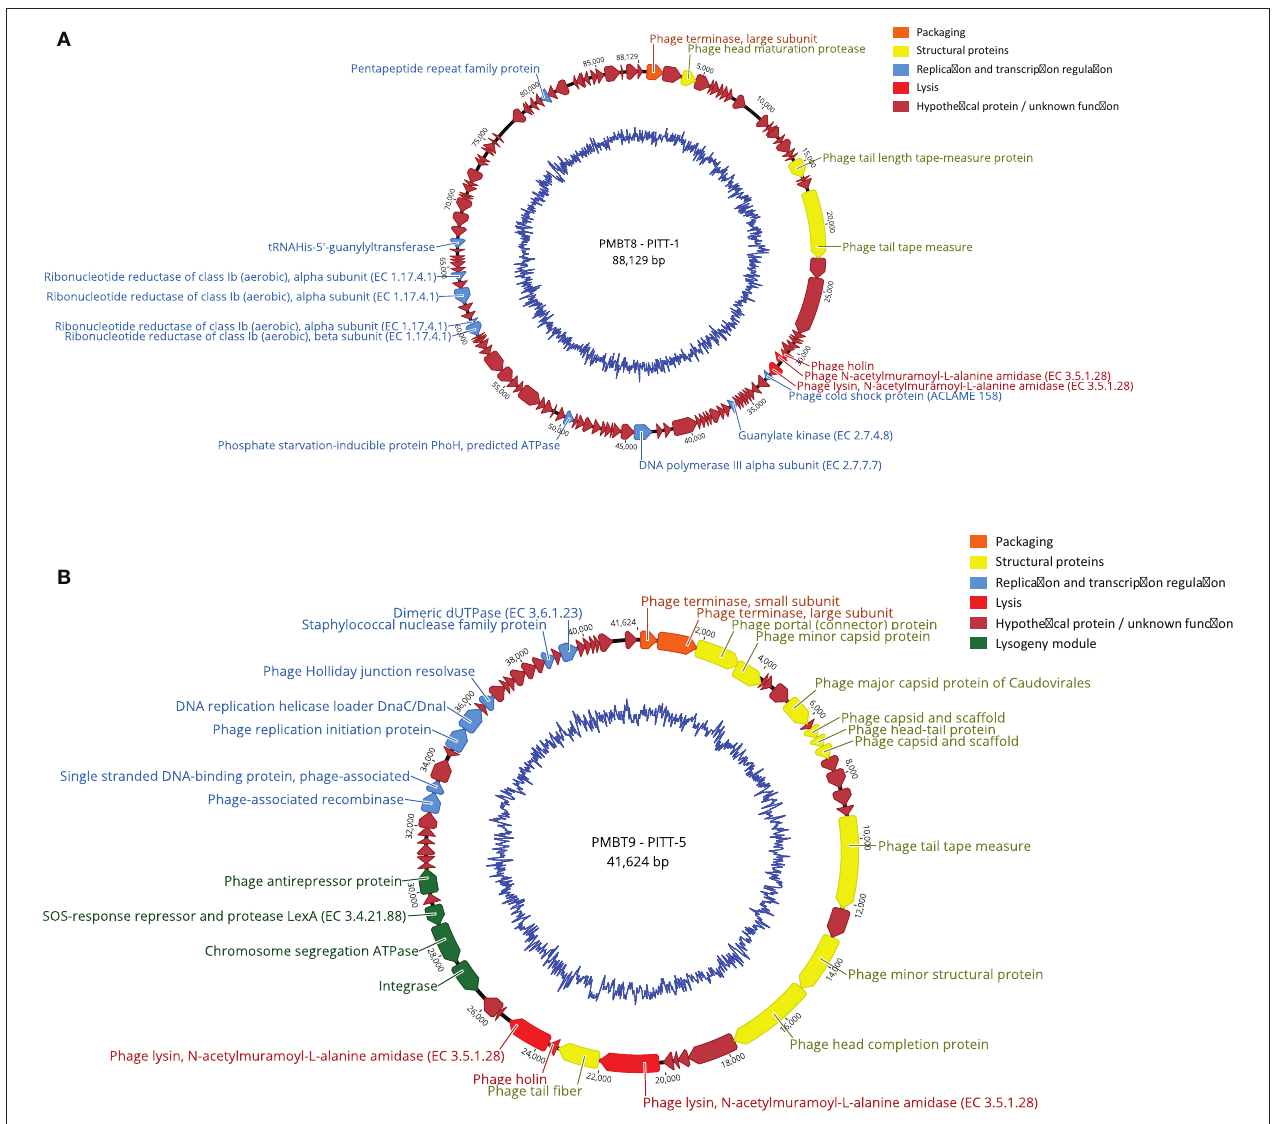
Packaging Structuralproteins